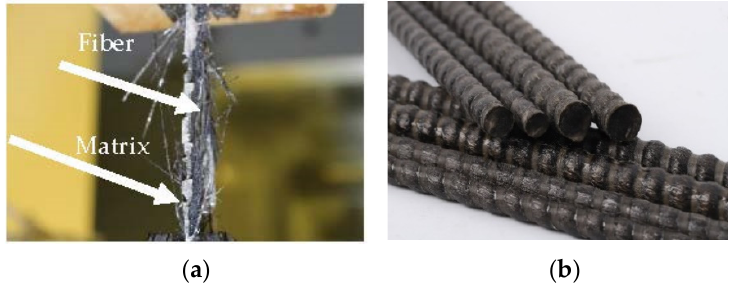
Figure 3. FRP materials: ( a ) FRP sheets ( b ) Basalt fiber bars.